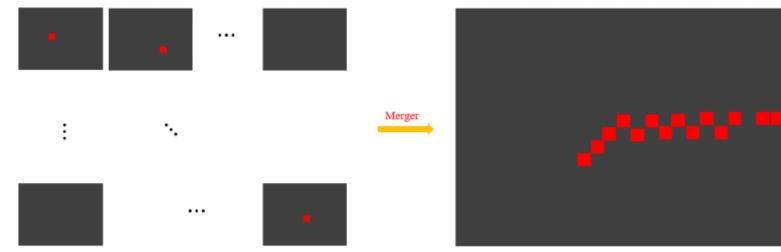
Figure 8. Schematic flow chart of classified images